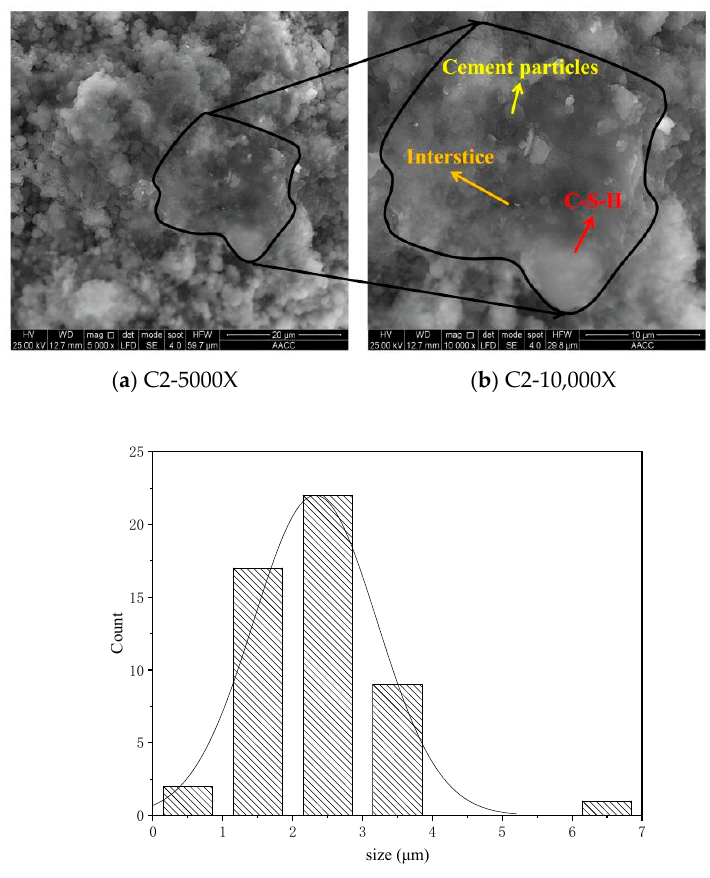
Figure 8. The microstructure and pore distribution of NS ‐ precipitated cementitious